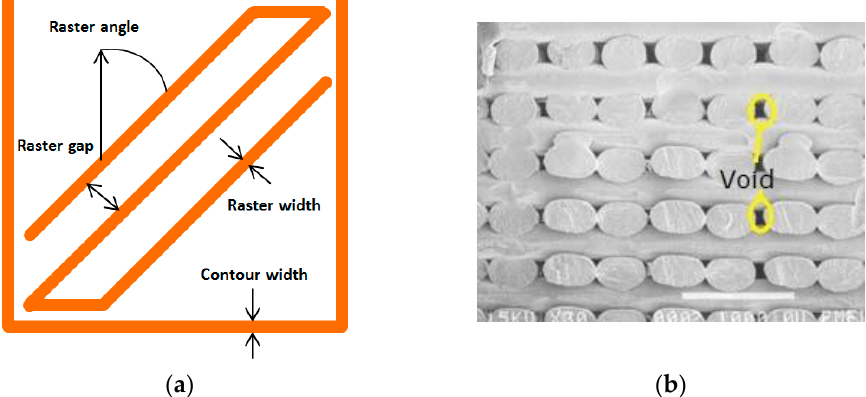
Figure 5. Raster gap voids [29]: ( a ) FDM process parameter [18] and ( b ) cross-sectional view of ABS printed part with 0/90 rasters. Reprinted with permission from [33], 2003, Emerald Publishing, Bingley, UK.